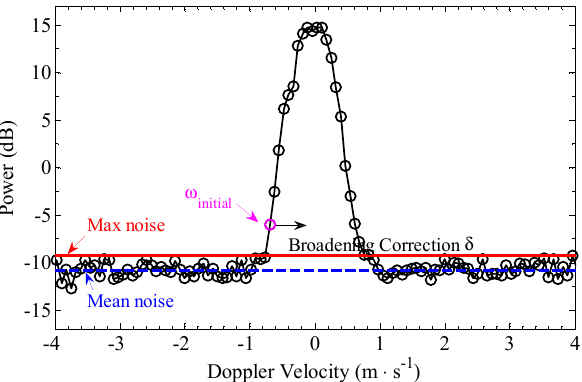
Figure 4. Schematic of the small-particle-traced idea. The blue dashed line is the estimated radar mean noise, the solid red line is the max noise, the ω initial represents the initial retrieval of vertical air velocity.